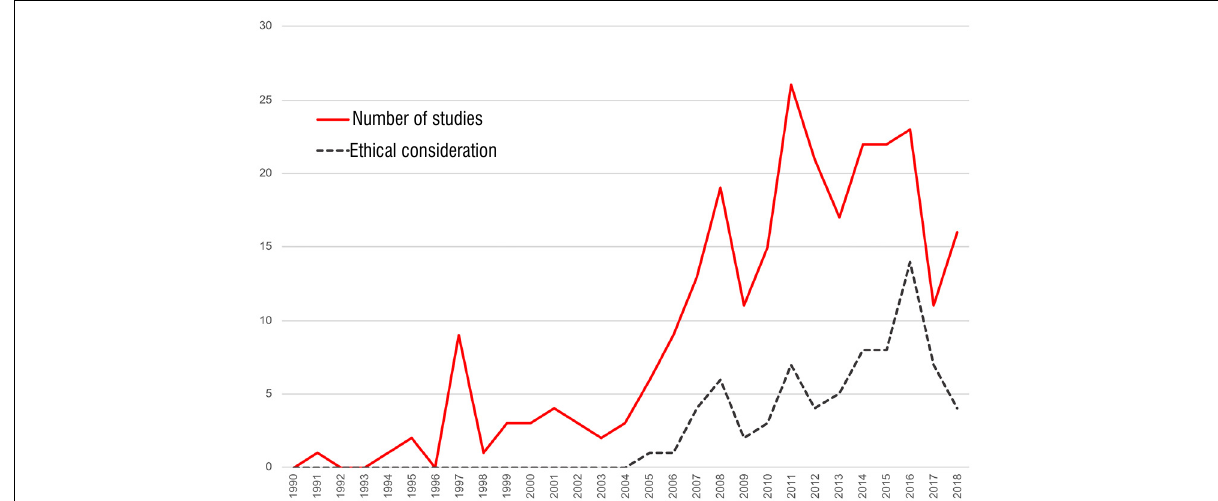
South African biocultural diversity literature published in 1990–2018 and the ethical considerations of these studies. The studies were searched on the Scopus database and the ethical consideration data were extracted using a pre-determined review